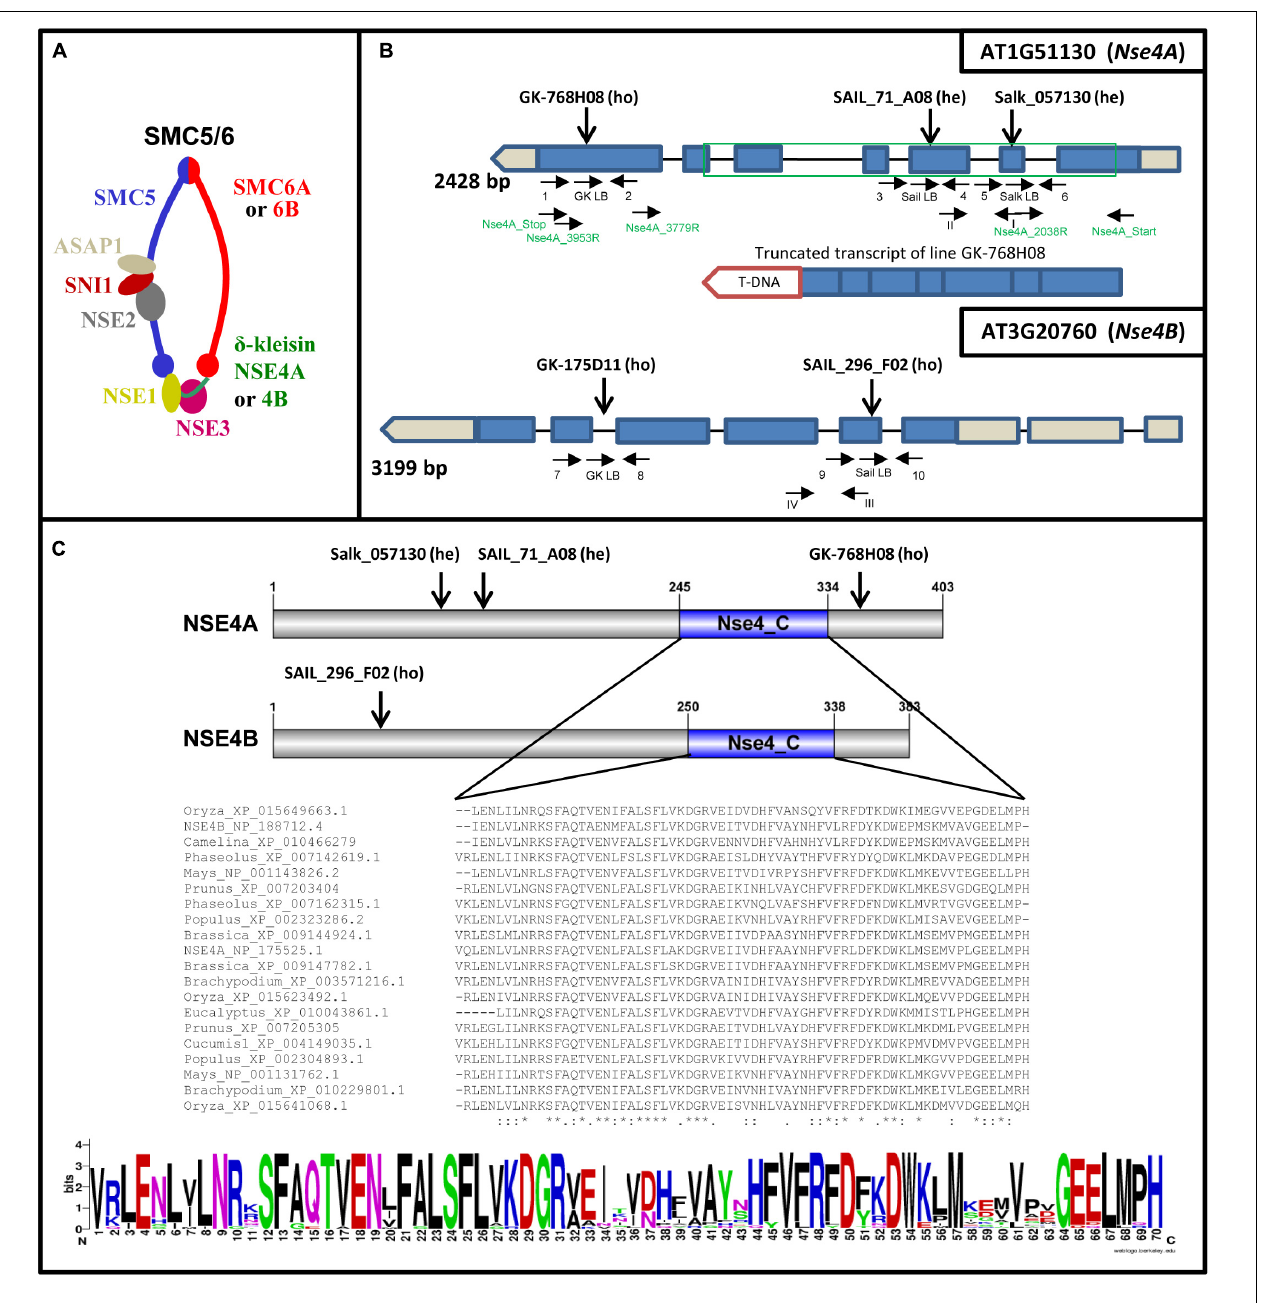
FIGURE 1 | A. thaliana SMC5/6 complexes and their δ -kleisin subunits NSA4A and NSE4B. (A) Subunit composition of SMC5/6 complexes based on a model according to Nasmyth and Haering (2005) and Schubert (2009). The SMC5/6 complexes presumably have one SMC5 subunit, two alternative SMC6 subunits, the NSE1, NSE2, NSE3, NSE5-like (SNI1), NSE6-like (ASAP1) subunits, and in addition, the two different δ -kleisins NSA4A and NSE4B. The sub-complexes NSE2-SNI1-ASAP1, NSE1-NSE3-NSE4, and SNI1-ASAP1 may act as specialized functional modules (Sergeant et al., 2005; Palecek et al., 2006; Duan et al., 2009). (B) Schematic view of the Nse4A and Nse4B gene structures (mips.helmholtz-muenchen.de, Version 10; ncbi.nlm.nih.gov; pfam.sanger.ac.uk) and the expressed truncated transcript of the T-DNA line GK-768H08. Exons are shown as blue boxes. UTRs are visible in gray. The green frame indicates the region used for recombinant protein expression and the production of antibodies. The T-DNA insertions ( A. thaliana SALK, SAIL, and GK lines) and gene-specific primers used for genotyping are indicated by arrows. Arabic numbers indicate gene-specific primers used for genotyping. Roman numbers denote primers applied for RT and real-time PCR. The primers used to confirm the truncated transcript of line GK-768H08 (T-DNA insertion visualized as red box) are indicated in green (see also Supplementary Figure S9 ). (C) Top: schematic view of the NSE4A and NSE4B protein structures. The conserved NSE4_C motif and the T-DNA insertion positions are indicated. Middle: Alignment of the NSE4_C motifs present in putative NSE4 orthologs of higher plants. The alignment was performed by the Clustal Omega 2.1 software. ∗ , Identical amino acids; :, similar amino acids; –, missing amino acids. Bottom: the same alignment as above presented in the sequence logo